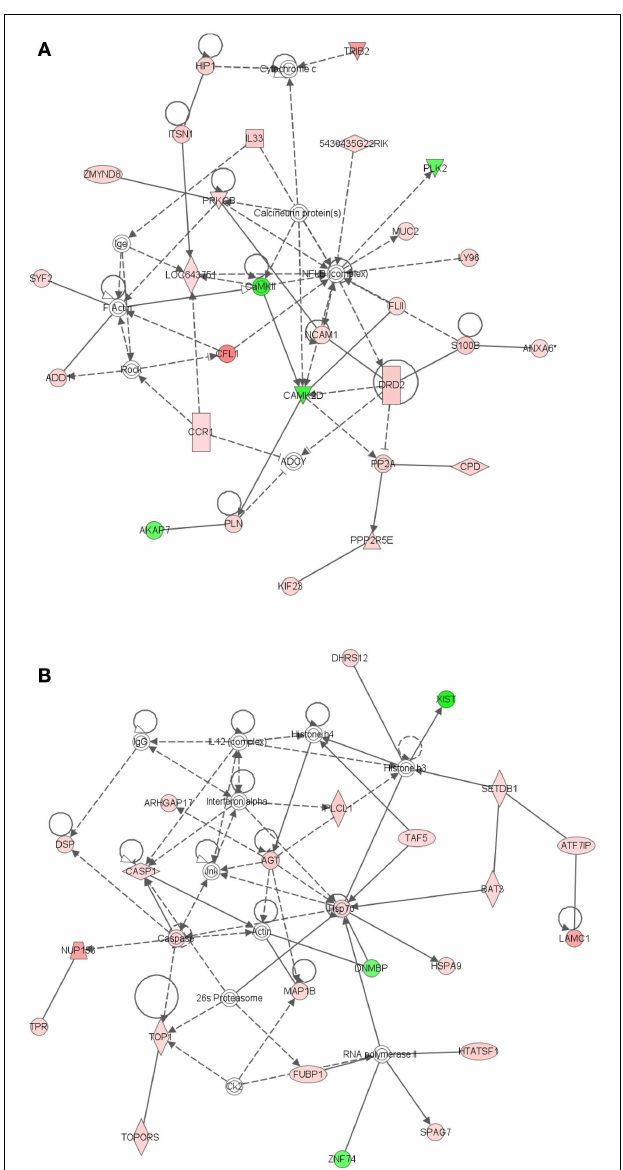
FIGURE 5 | Ingenuity PathwayAnalysis (IPA) of genes differentially expressed in ECb vs. ECe. Genes that were differentially expressed in ECb vs. ECe were imported into IPA software, which revealed the involvement of several networks pertinent to ECb. Network (A) pertains to endocrine development and function, lipid metabolism. Network (B) is associated with cancer and contains two heat shock protein modules. Red color denotes up-regulation in LRECb and green color denotes down-regulation in LRECb relative to control cells.The IPA legend is shown in FigureA1 in Appendix.